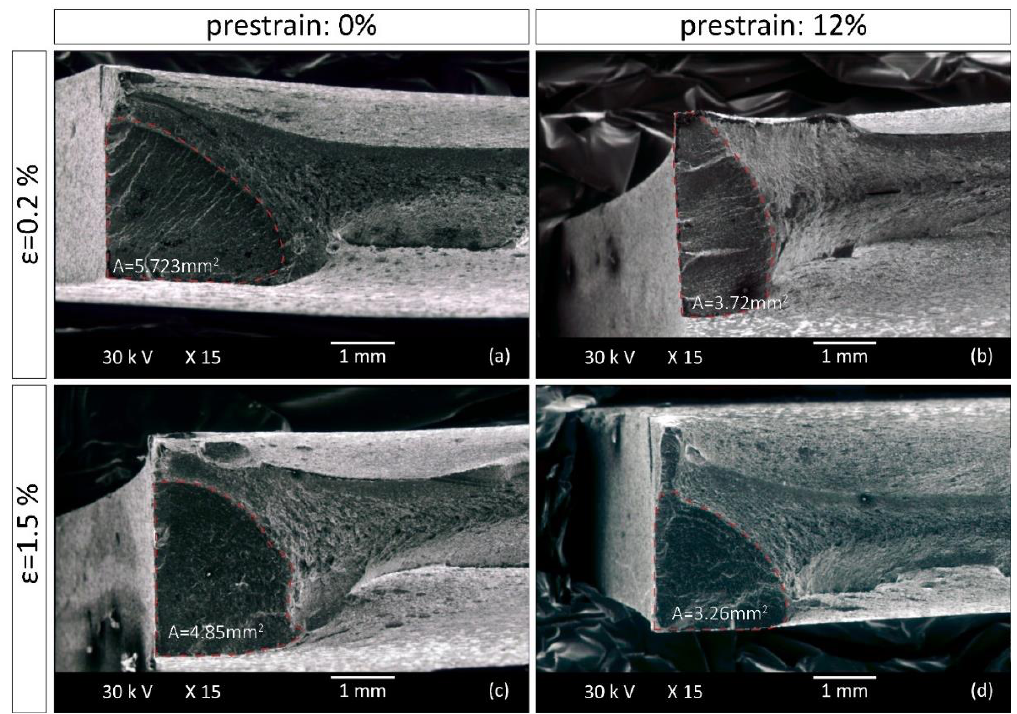
Figure 9. Fatigue section size of fractured S460MC specimens in ( a ) reference and ( b ) 12% pre- strain condition that have been subjected to 0.002 strain amplitude, and in ( c ) reference and ( d ) 12% pre-strain condition that have been subjected to 0.015 strain amplitude. Table 6. Measurement of fatigue